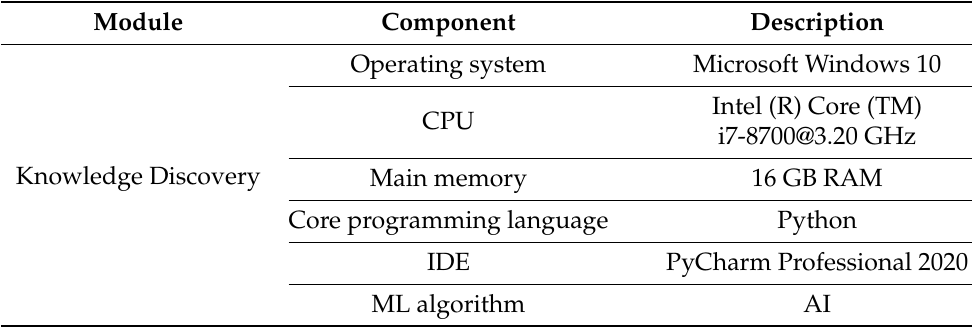
Table 3. Development